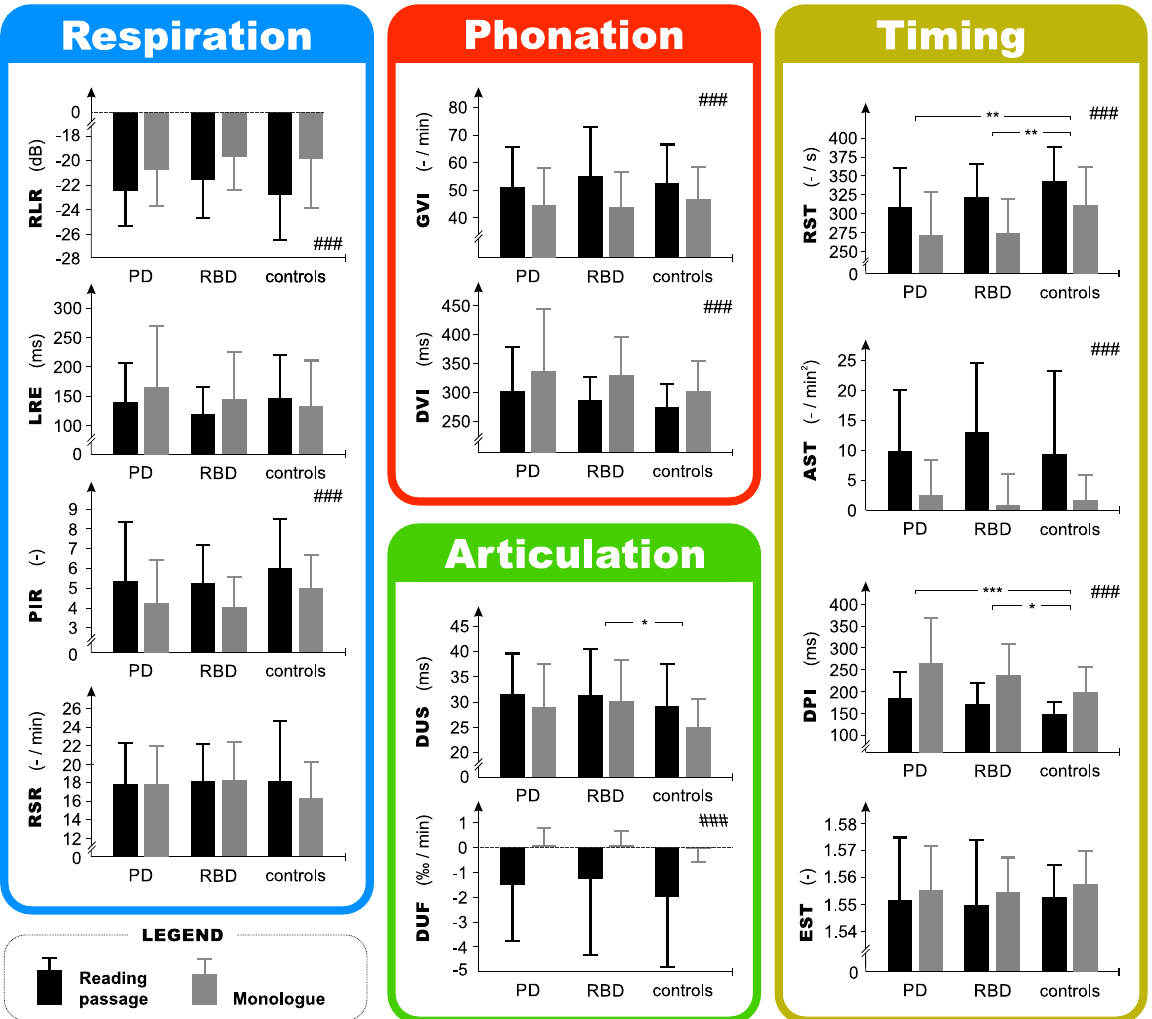
Figure 3. Results of acoustic speech analyses. Bars represent mean values and error bars represent SD values. Repeated measures analysis of variance (RM-ANOVA) was used to test for group differences: GROUP (PD vs. RBD vs. controls): corrected * p < 0.05, ** p < 0.01, *** p < 0.001 after Bonferroni adjustment; TASK (reading passage vs. monologue): corrected # p < 0.05, ## p < 0.01, ### p < 0.001 after Bonferroni adjustment. None of the features showed significant GROUP × TASK interaction. RST = rate of speech timing, AST = acceleration of speech timing, DPI = duration of pause intervals, EST = entropy of speech timing, DUS = duration of unvoiced stops, DUF = decay of unvoiced fricatives, DVI = duration of voiced intervals, GVI = gaping in-between voiced intervals, RSR = rate of speech respiration, PIR = pause intervals per respiration, RLR = relative loudness of respiration, LRE = latency of respiratory exchange, PD = Parkinson’s disease, RBD = rapid eye movement sleep behaviour